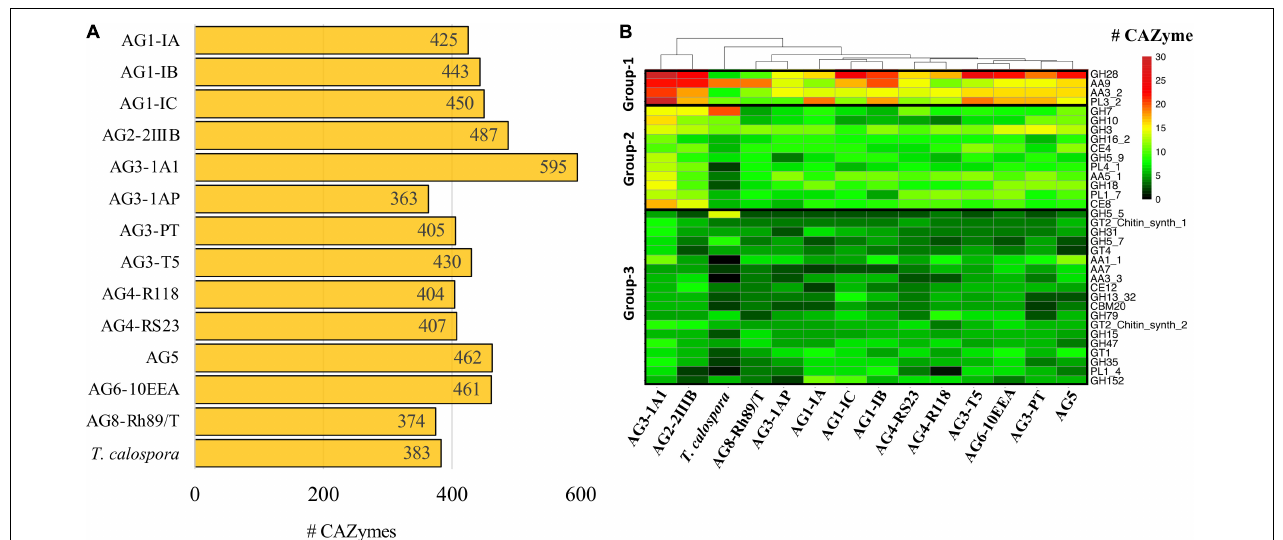
FIGURE 6 | CAZymes . (A) The number of carbohydrate-metabolizing enzymes (CAZymes) predicted in the proteome of each fungal isolate. (B) Heatmap showing the CAZyme conservation across all the R. solani AGs and T. calospora . Each row represents one CAZyme family of proteins, and color is proportional to the number of protein members shared within a given family from the given species (black: no member protein present; red: large number of protein members present). The hierarchical clustering (hclust; method: complete) enumerates the similarities between different fungal isolates based on proteins shared by them across all CAZyme families. For simplicity only the CAZyme families enriched in more than 50 enzymes across all proteomes are